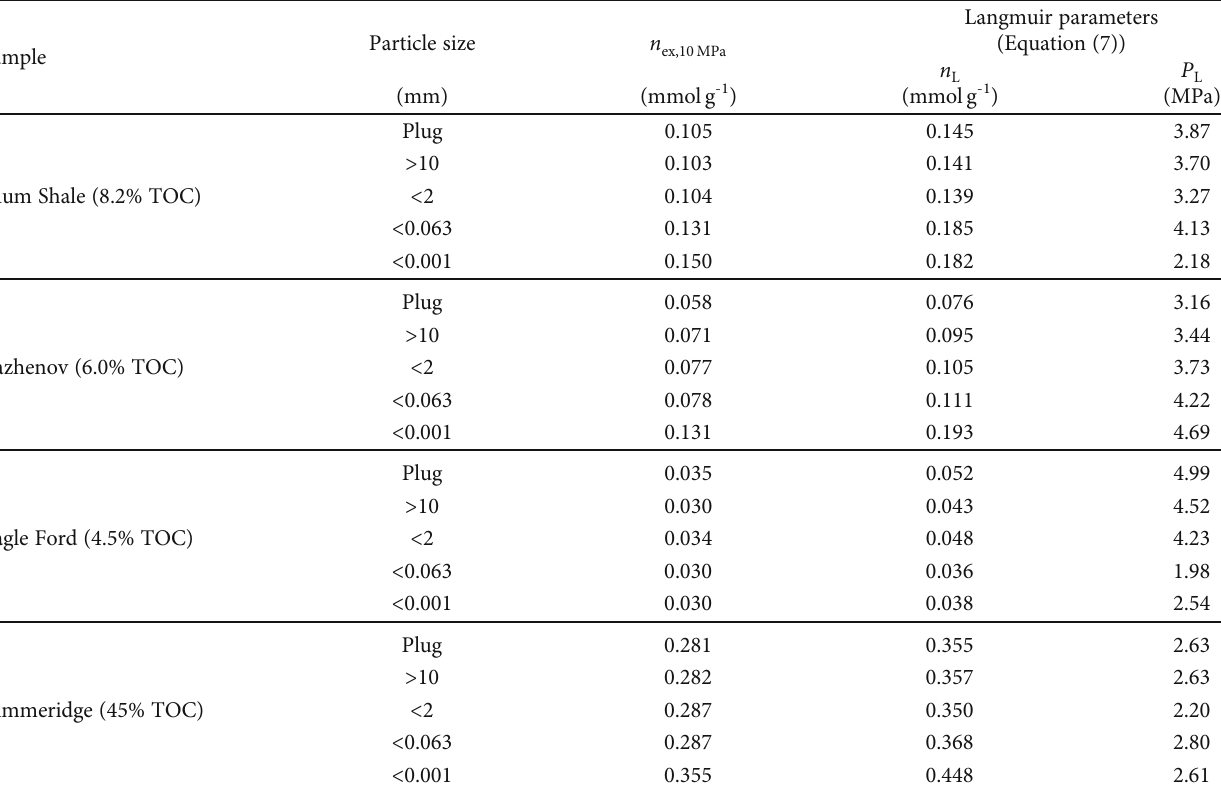
Table 2: Methane excess sorption capacity at 10MPa pore pressure ( n (7)) for all samples and particle sizes.